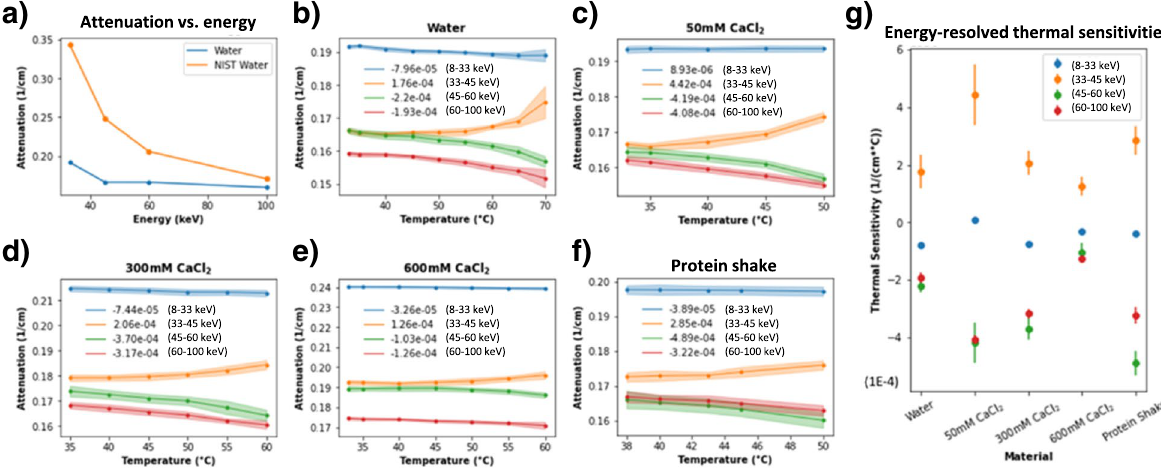
Fig. 2 Graphs of attenuation data of all studied materials. a Attenuation vs energy plots for water compared to NIST values (we multiply the mass attenuations by the density of water, assumed to be 1.00 g/cm 3 at 33 °C). The end points of the energy bins (33, 45, 60, and 100 keV) were selected for the figure. Compton scattering of high energy photons accounts for the observed attenuation discrepancy; b-f Attenuation vs temperature plots for all materials. The positive trend in the 33-45 keV bin is due to the effects of temperature on Compton scattering at high energies. The legend indicates the slope of the regression line for the color-coded trend; g Scatterplot summary of thermal sensitivities with error bars. Observe the non-linear trend between thermal sensitivity and composition for 0, 50, 300, and 600 mmol/L solutions of CaCl